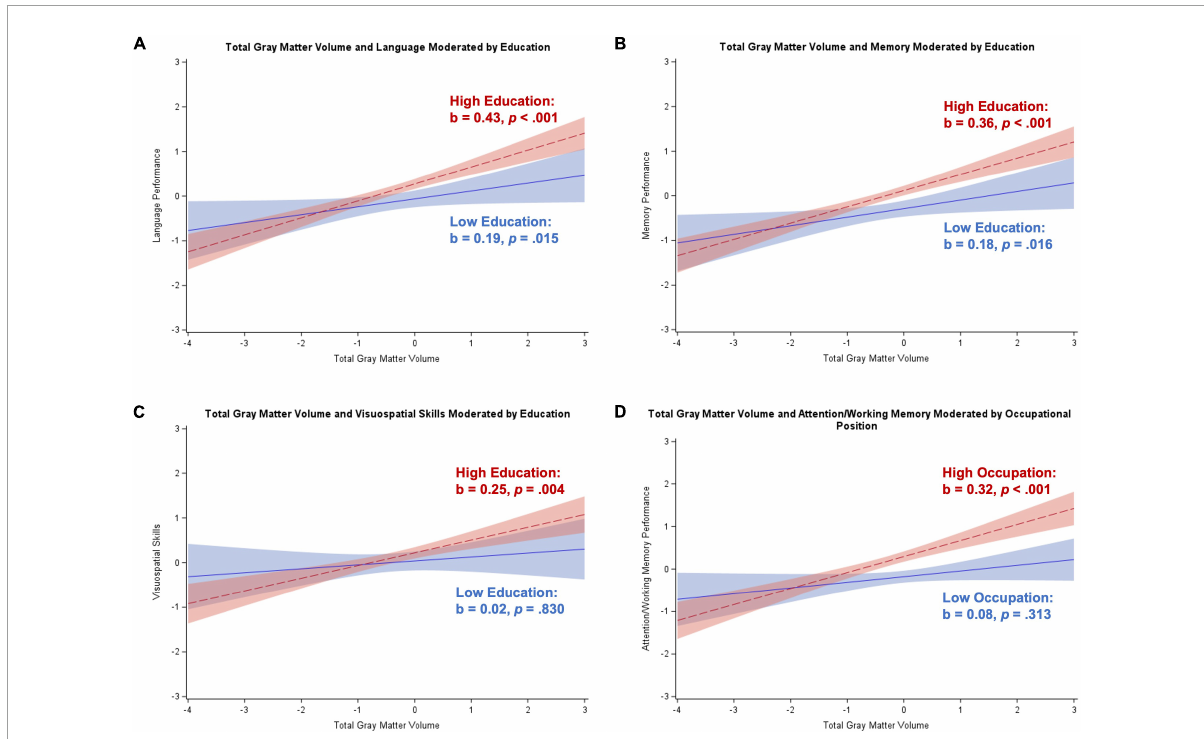
FIGURE6 Plots of significant moderations by education and occupational position of the associations between total gray matter volume and cognition for men without dementia. High education or occupational position corresponds to 1 SD above the mean and low education or occupational position corresponds to 1 SD below the mean. The red dotted line represents high education or occupational position, and the blue solid line represents low education or occupational position. Shaded areas represent 95% confidence intervals. Cognition and total gray matter volume were standardized. (A) Significant positive association between total gray matter volume and language for participants with high education; significant positive association for low education. (B) Significant positive association between total gray matter volume and memory for participants with high education; significant positive association for low education. (C) Significant positive association between total gray matter volume and visuospatial skills for participants with high education; non-significant positive association for low education. (D) Significant positive association between total gray matter volume and attention/working memory for participants with high occupational position; non-significant positive association for low occupational